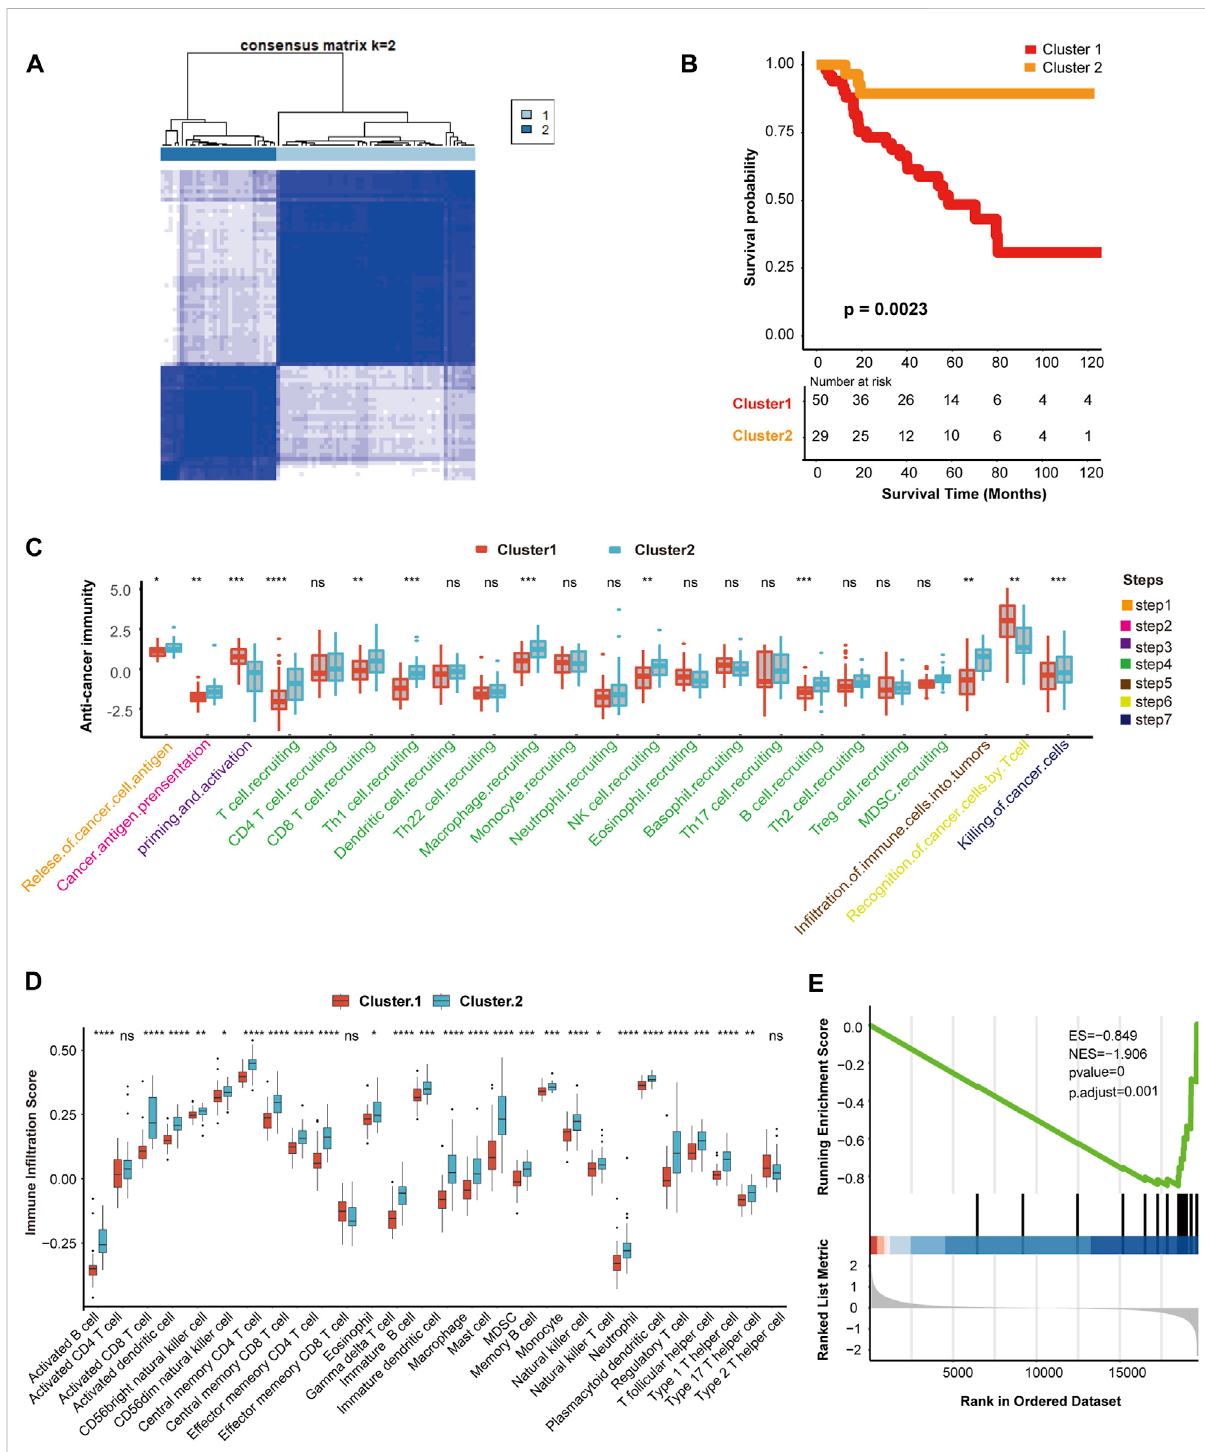
FIGURE 1 Hypoxia clusters correlated with immune phenotypes. (A) The TCGA-ACC cohort was divided into two distinct cluster when k = 2. (B) Survival analysis between cluster 1 and cluster 2. Cluster 1, red. Cluster 2, yellow. (C) Comparison of immune cycle activity involved in seven steps between cluster1andcluster2.Cluster1,red.Cluster2,blue. (D) Comparisonofvariousimmunecellin fi ltrationscorebetweencluster1andcluster2.Cluster 1,red.Cluster2,blue. (E) TheenrichmentscoreofIFN- γ pathwayincluster1andcluster2.|NES| > 1and p < 0.01wereconsideredasstatistically signi fi